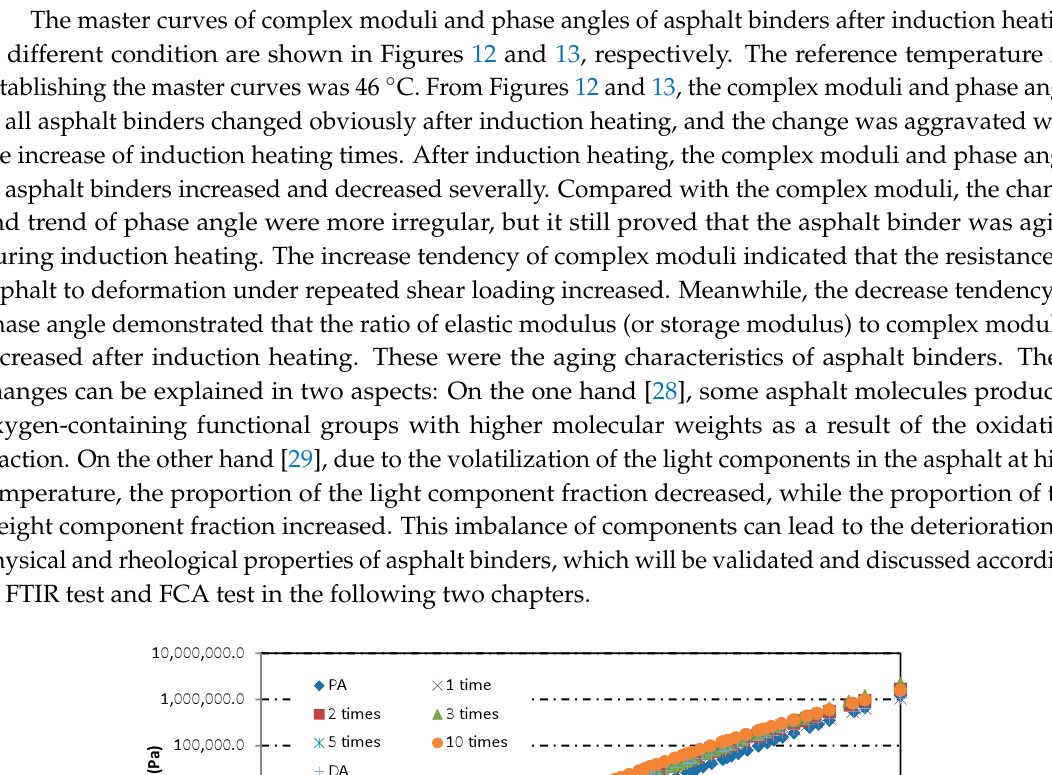
Figure 13. Phase angle master curve of asphalt binders in different induction heating conditions. 3.3. Chemical Structure Analysis 3.2.1. Multiple Induction Heating Figure 14 shows the changing areas of carbonyl functions and Figure 15 presents the changes in FTIR index of asphalt binders obtained from different induction heating conditions. From Figure 14, it can be observed that with the increase of induction heating times, the carbonyl index in asphalt binder increased gradually, but there was no peak value. For pure asphalt, I C=O was 0.000531, which was far below the value of other samples, indicating that slow aging occurred during production and storage. After induction heating for 10 cycles, I C=O reached to 0.006231, which demonstrated that the asphalt binder aging was very obvious at this time. However, for DA, its carbonyl index was equivalent to the value of the asphalt binder inside the asphalt concrete after inducting heating for three cycles, which was more serious than that after induction heating for one and two cycles. This showed that in the case of more oxygen, the asphalt binder did incur more serious thermal oxygen